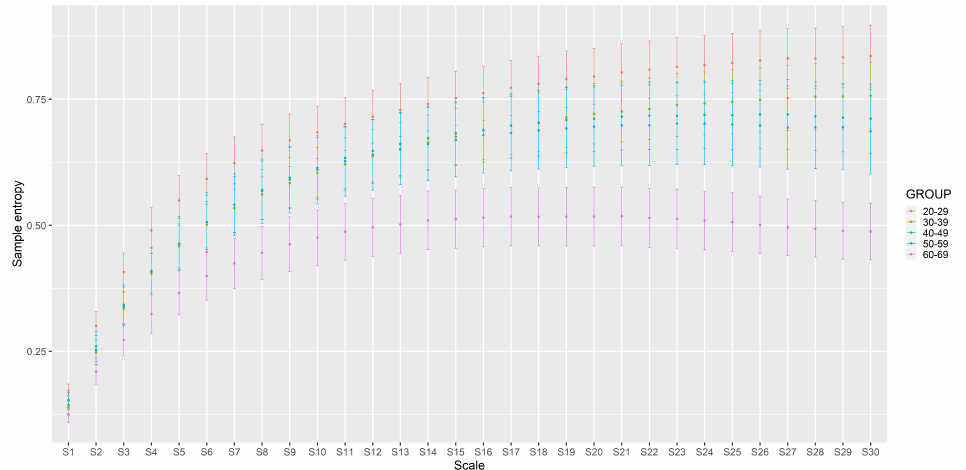
Figure 7. MSE analysis results in particular age